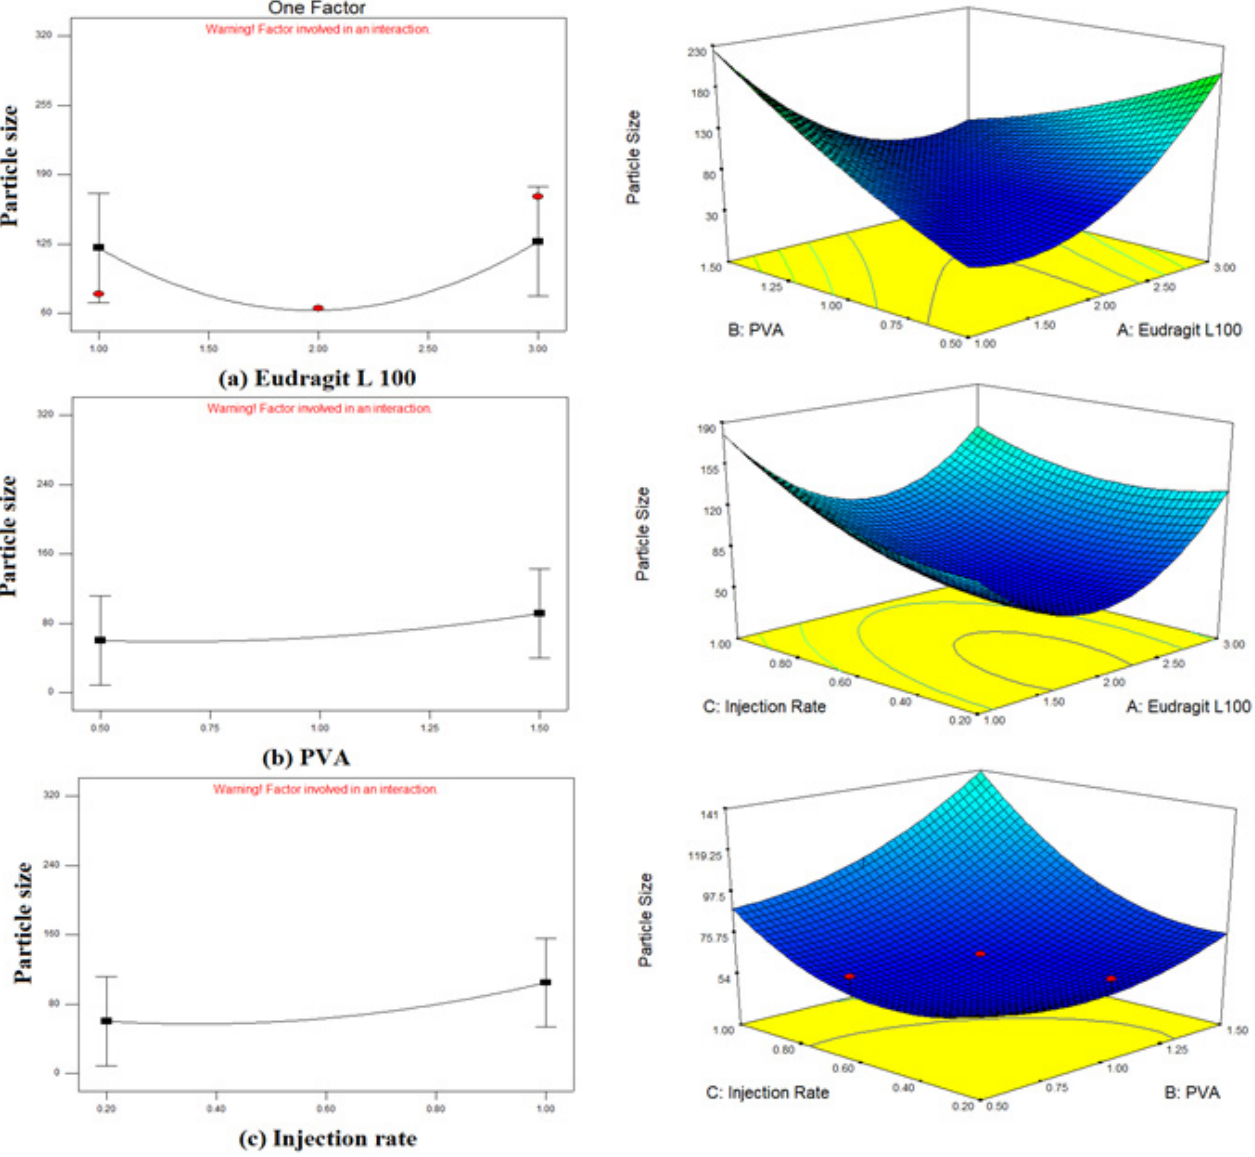
Figure 3. Graphical representation of the impact of independent variables on mean particle size of bergenin-loaded nanoparticles. ( a ) EL 100 ( b ) PVA ( c ) organic phase injection rate and 3-D response surface plot ( a ) PVA and EL 100; ( b ) organic phase injection rate and EL 100; ( c ) organic phase injection rate and PVA.